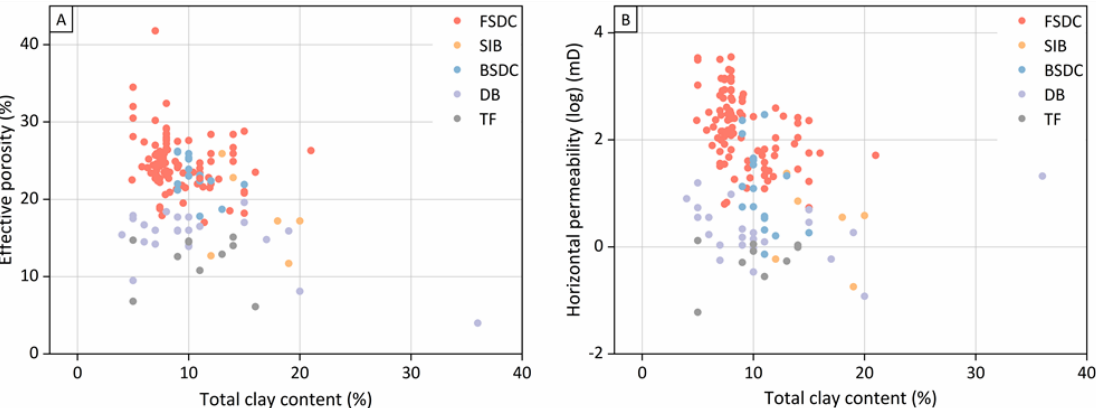
Figure 12. Plots of reservoir properties versus total clay content derived from XRD, split by different sedimentary microfacies. ( A ) Core effective porosity versus total clay content; ( B ) Core horizontal permeability versus total clay content. (FSDC — submerged distributary channel (fan delta), SIB — submerged interdistributary bay, BSDC — submerged distributary channels (braided delta), DB — distal bar, TF — turbidite fan).